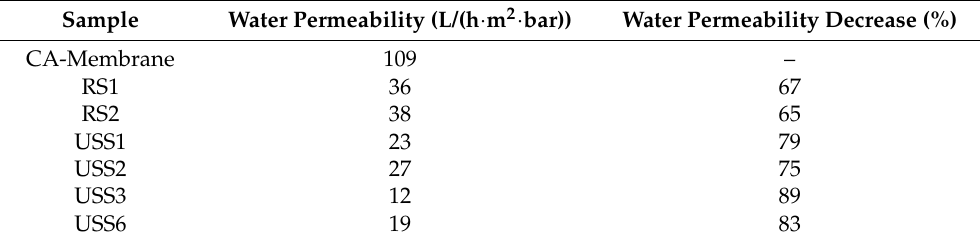
Table 5. Water permeability properties, in L/(h · m 2 · bar), for seven selected CA based membranes.